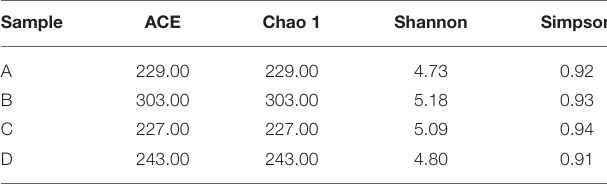
TABLE 1 | Estimated alpha-diversity indices of 18S ribosomal RNA (rRNA) gene libraries for four samples used for sequencing.